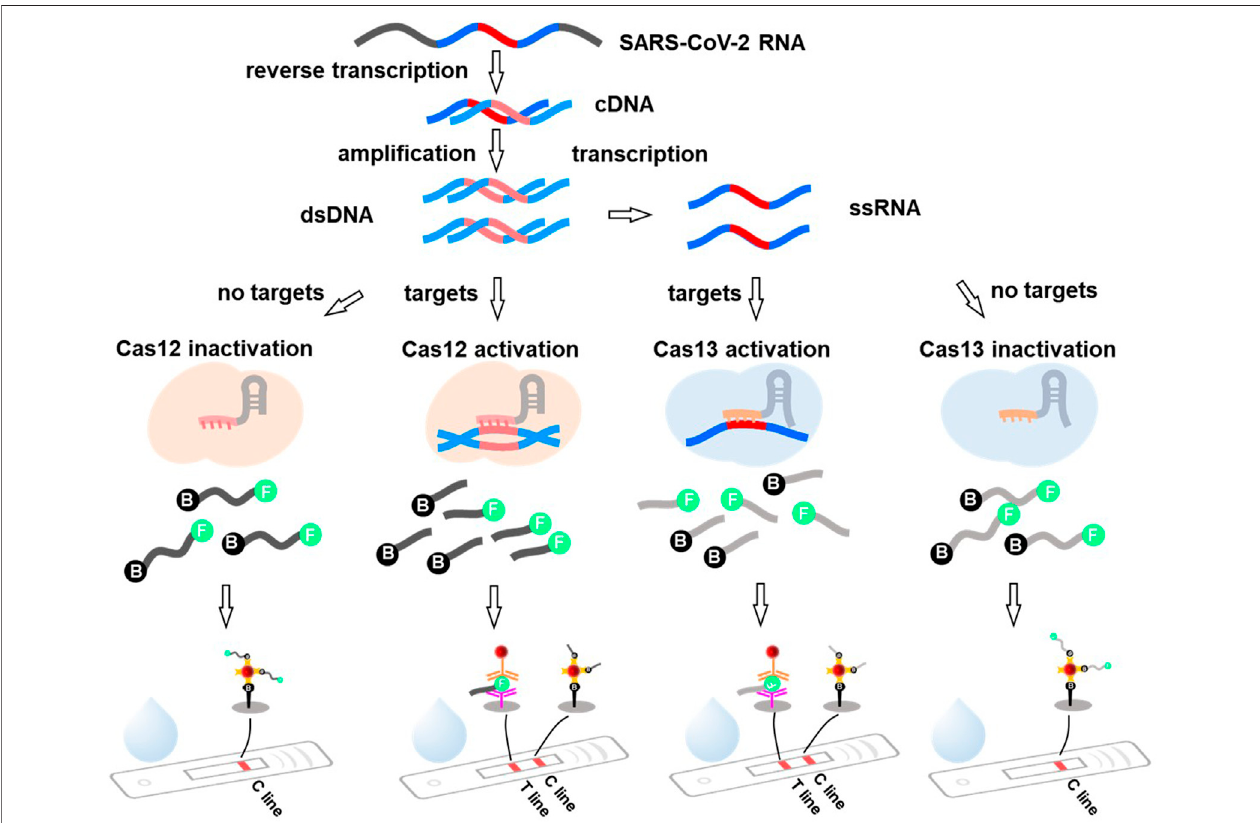
FIGURE 5 | The principle of the CRISPR system mediated lateral fl ow assay. Viral RNA is fi rst reverse transcribed to cDNA and serve as a template to produce cDNA amplicons. The amplicons are directly added into the CRISPR-Cas12 system and activated the Cas12 by dsDNA with the targeting sequence (the red mark) to cleave the ssDNA (marked with speci fi c recognition molecules at the end, such as biotin and FITC). Alternatively, the amplicons can be transcribed to ssRNA and then added to the CRISPR-Cas13 system. The Cas13 recognizes RNA containing CRISPR targeting sequences and cleaves its ssRNA reporters. The solution containing the cleaved reporters is added to the sample pad. Under the action of capillary tension, part of the reporter-biotin coupled with streptavidin-AuNPs will be captured at C line, and the FITC conjugated antibody-AuNPs @FITC@FITC captured antibody leads to the signal at T